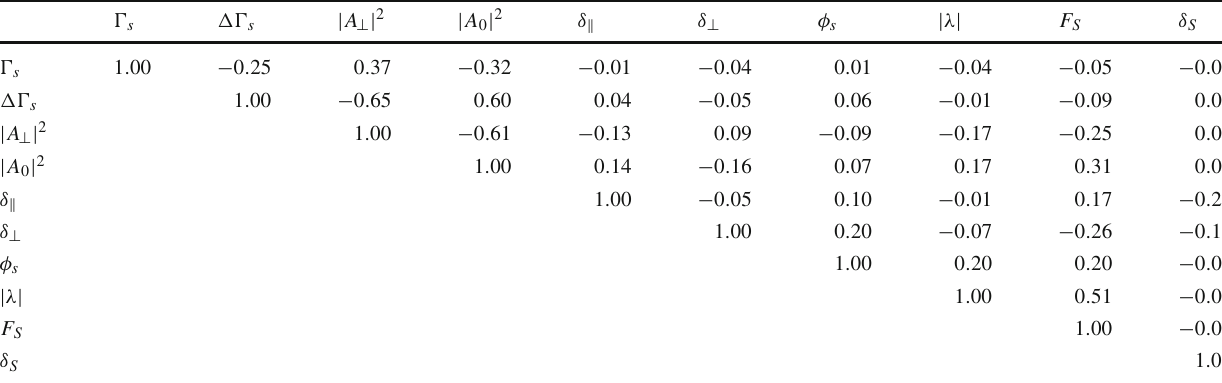
Table 7 Correlation matrix of statistical uncertainties for a fit with fixed (cid:5) m